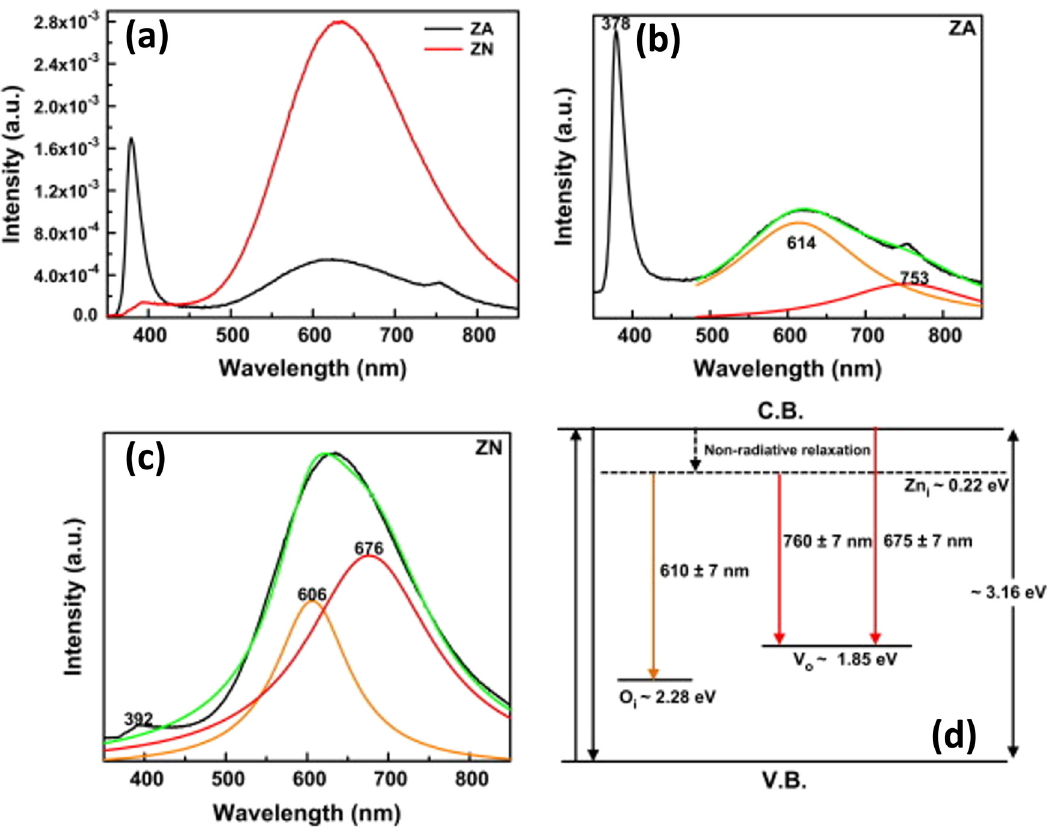
Figure 8: ( a ) PL spectra of the di ff erent ZnO NPr, ( b ) and ( c ) are the deconvoluted peaks of the broad band PL spectra, and ( d ) schematic energy band diagram of PL spectra. Reproduced with permission from Elsevier [ 166 ]